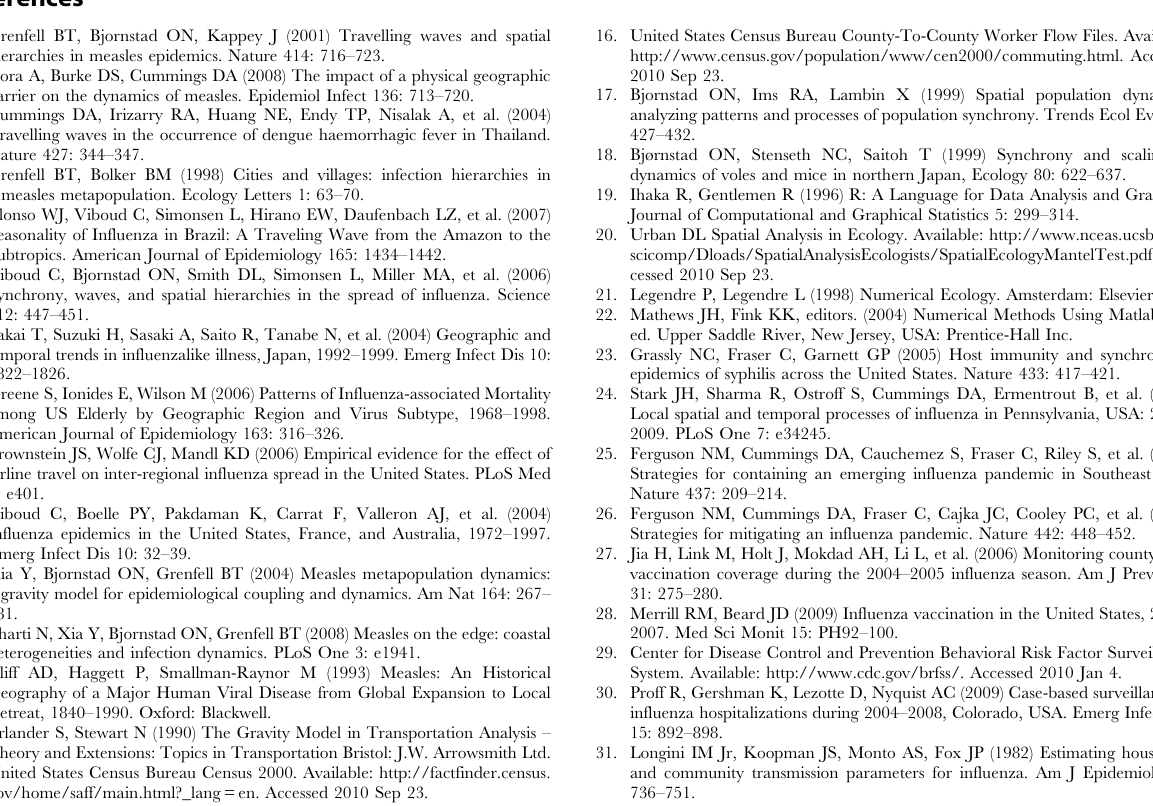
Figure S1 Correlation of weekly time series with distance for each influenza season. The spline function (middle curve) is presented with a 95% confidence interval (outer curves). Each graph represents a different